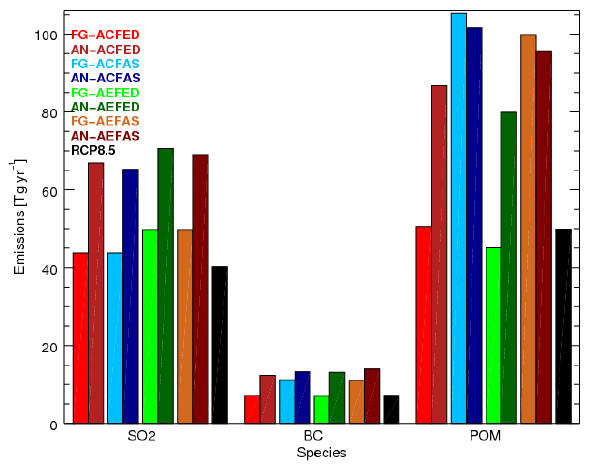
Fig. 7. Annual anthropogenic emissions of SO 2 (in TgSyr − 1 ) for Fig. 6. Global-yearly emissions of SO 2 (in TgSyr − 1 ), BC and Fig.7. Annualanthropogenicemissionsof SO 2 (inTgSyr − 1 )fortheFGemissionsoftheACFEDandAEFED Fig. 6. Global-yearly emissions of SO 2 (in TgSyr − 1 ), BC and POM (in Tgyr − 1 ) for the FG and AN of the FG emissions of the ACFED and AEFED experiments (light and POM (in Tgyr − 1 ) for the FG and AN of the for experiments: experiments(lightanddarkgrey,respectively)andtheANemissionsoftheexperimentsACFED(red),ACFAS the for experiments: ACFED (light and dark red, respectively), ACFAS (light and dark blue, respectively), dark grey, respectively) and the AN emissions of the experiments ACFED (light and dark red, respectively), ACFAS (light and dark (blue), AEFED (green) and AEFAS (brown). Fluxes are presented for all regions illustrated in Fig. 1a. AEFED (light and dark green, respectively) and AEFAS (light and dark brown, respectively). Projected RCP8.5 ACFED (red), ACFAS (blue), AEFED (green) and AEFAS (brown). blue, respectively), AEFED (light and dark green, respectively) emissions for the year 2010 (RCP, black) are also included. Fluxes are presented for all regions illustrated in Fig. and AEFAS (light and dark brown, respectively). Projected RCP8.5 emissions for the year 2010 (RCP, black) are also included.